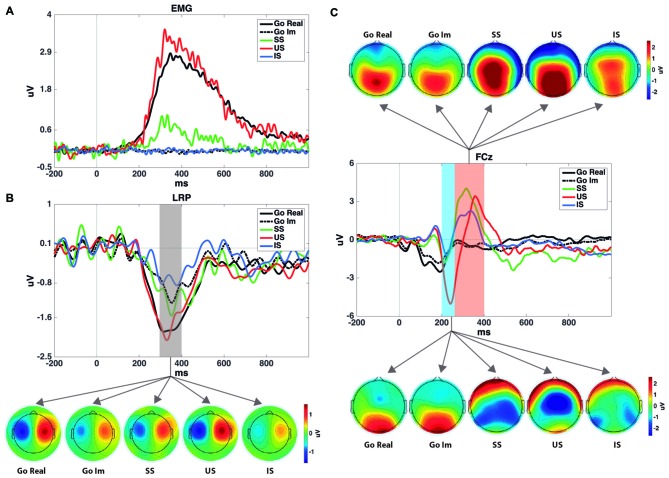
(A) Rectified electromyogram (EMG) for each condition. It shows that no EMG activity was registered after stimulus presentation during the imagined task. (B) LRP time-locked to the go signal and the topographies of the shaded area. SS and US grand averages of the LRPs were computed using 12 participants, while Go Real, Go Im and IS were computed using 18 participants. Topographies were calculated using the method described by Praamstra and Seiss (2005). (C) Event-related potential (ERPs) for each task and condition at the FCz electrode site and their topographies in the windows selected to measure N2 and P3 components. Note that go trials were averaged time-locked to the go signal, while SS, US and IS were averaged time-locked to the stop signal and with go-stimulus ERPs subtracted.